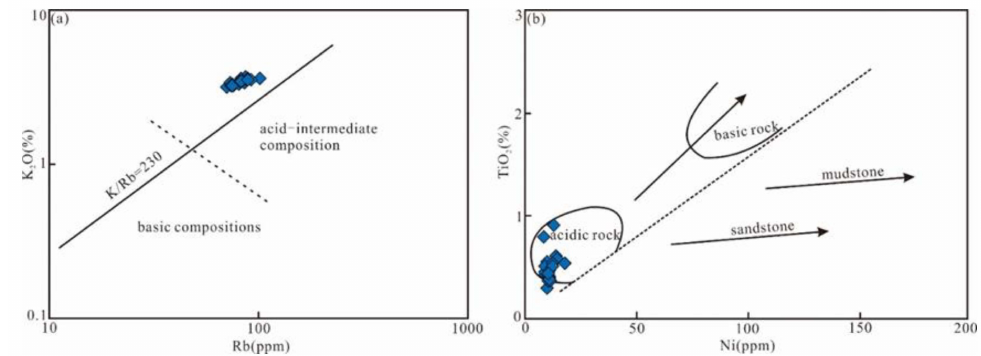
Figure 9. Source material composition discrimination diagrams for the Zhiluo Formation sandstones. ( a ) K 2 O versus Rb bivariate diagram [42]; ( b ) TiO 2 versus Ni bivariate diagram [43]. Trace elements such as Ti, Hf, Sc, Th, Zr, Y and REEs are critical for interpreting the ori- gin and composition of the source area due to their minimal possibility of migrating during the post-depositional process [44]. Hf versus La/Th [42], La/Sc versus Co/Th [10], Cr/Th versus Th/Sc [45] and Y/Ni versus Cr/V [10] discrimination diagrams (Figure 10) were used to analyze the parent rock types of sandstones. The studied sandstones, according to these diagrams, are the felsic igneous source rocks and intermediate igneous